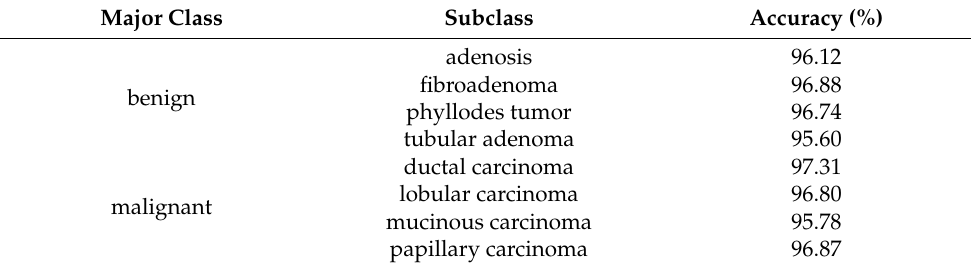
Table 5. The classification accuracy of each type of breast cancer disease